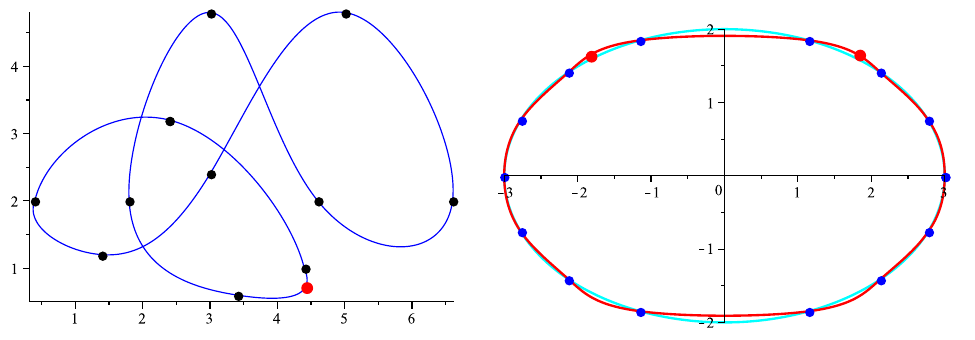
Figure 6. On the ( left ): κ max = 5.045872521. On the ( right ): κ max = 0.9591183657. These maximum curvatures are attained at the red points.